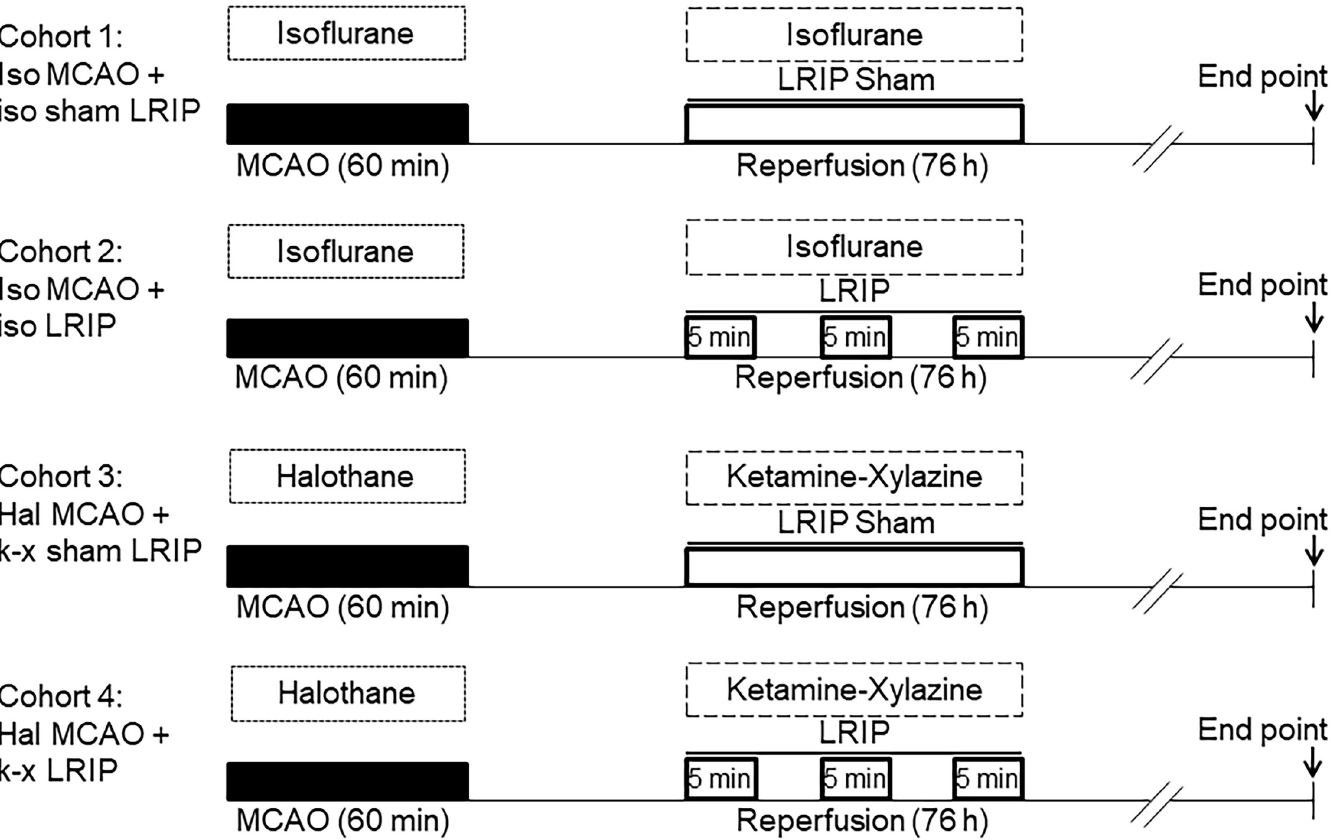
Fig 1. Experimental design. In cohort 1 (Iso MCAO + iso sham LRIP), mice underwent MCAO surgery under isoflurane anesthesia (Fig 1). At 90 min after reperfusion, sham-LRIP was induced under isoflurane anesthesia. In cohort 2 (Iso MCAO + iso LRIP), mice underwent MCAO surgery under isoflurane anesthesia. At 90 min after reperfusion, LRIP was induced under isoflurane anesthesia. In cohort 3 (Hal MCAO + k-x sham LRIP), mice underwent MCAO surgery under halothane anesthesia. At 90 min after reperfusion, sham-LRIP was induced under ketamine-xylazine anesthesia. In cohort 4 (Hal MCAO + k-x LRIP), mice underwent MCAO surgery under halothane anesthesia. At 90 min after reperfusion, LRIP was induced under ketamine-xylazine anesthesia. In cohorts 2 and 4, LRIP was induced at 90 min after reperfusion by three cycles of 5 min ischemia/5 min reperfusion of bilateral hind limb for one session per day for a total of four sessions. https://doi.org/10.1371/journal.pone.0227624.g001 PLOS ONE | https://doi.org/10.1371/journal.pone.0227624 January 16,